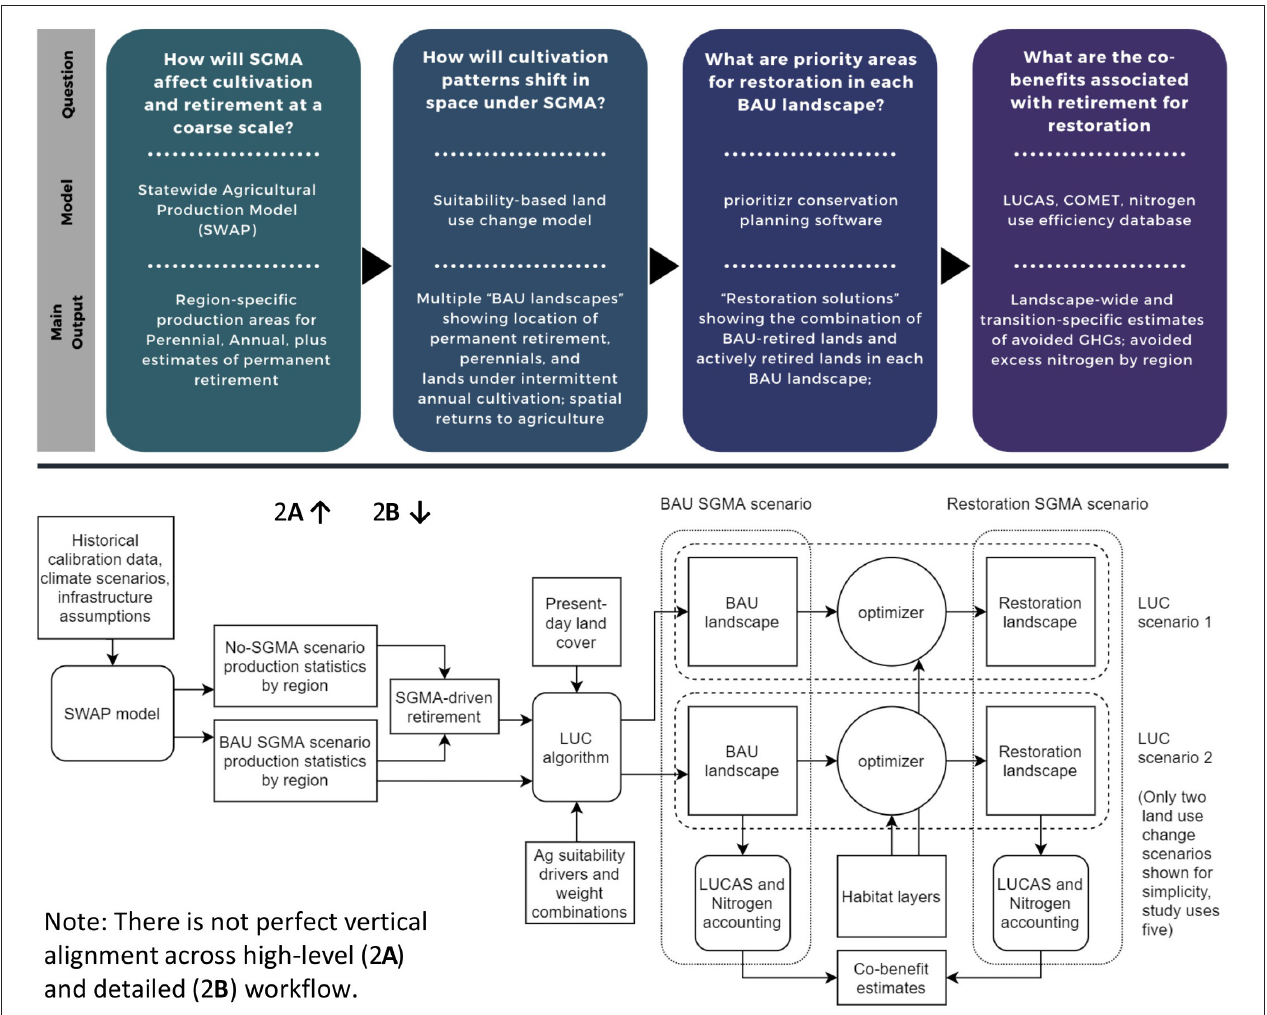
FIGURE 2 | Overall modeling workflow, linking regional economic modeling, land use change, conservation planning, and co-benefits assessment. (A) (Upper) Shows the high-level workflow in terms of questions, models, and the form of output at each step. (B) (Lower) Shows the connections across workflow at a more mechanistic level, while highlighting the scenario logic. The paper focuses on characterizing BAU SGMA and Restoration SGMA scenarios, while recognizing uncertainty in their exact spatial patterns (LUC